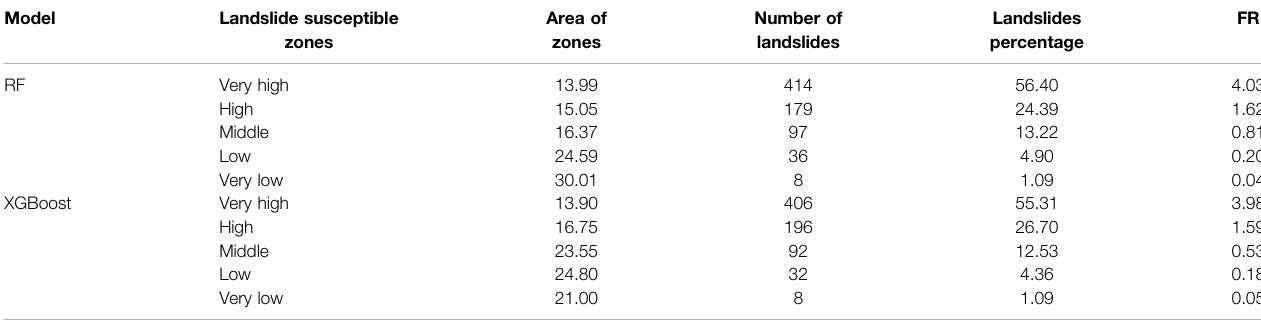
TABLE 3 | Statistical results of the frequency ratio of the RF and the XGBoost models.